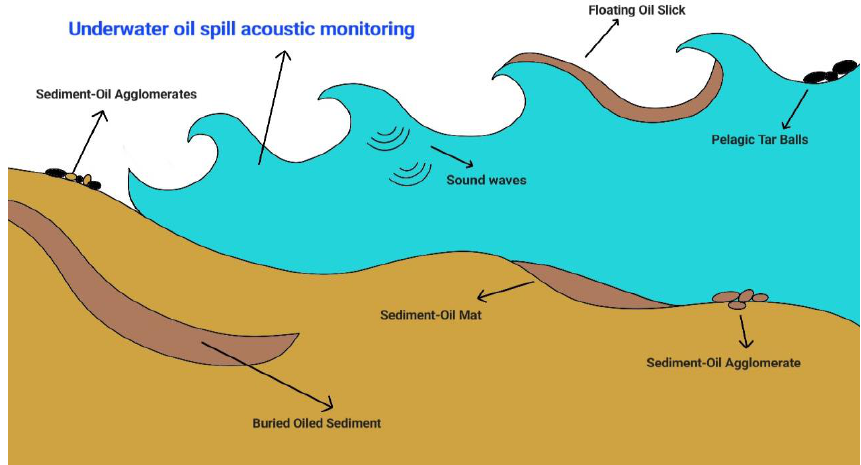
Figure 2. Conceptual model of various oil residues found in nearshore environments.